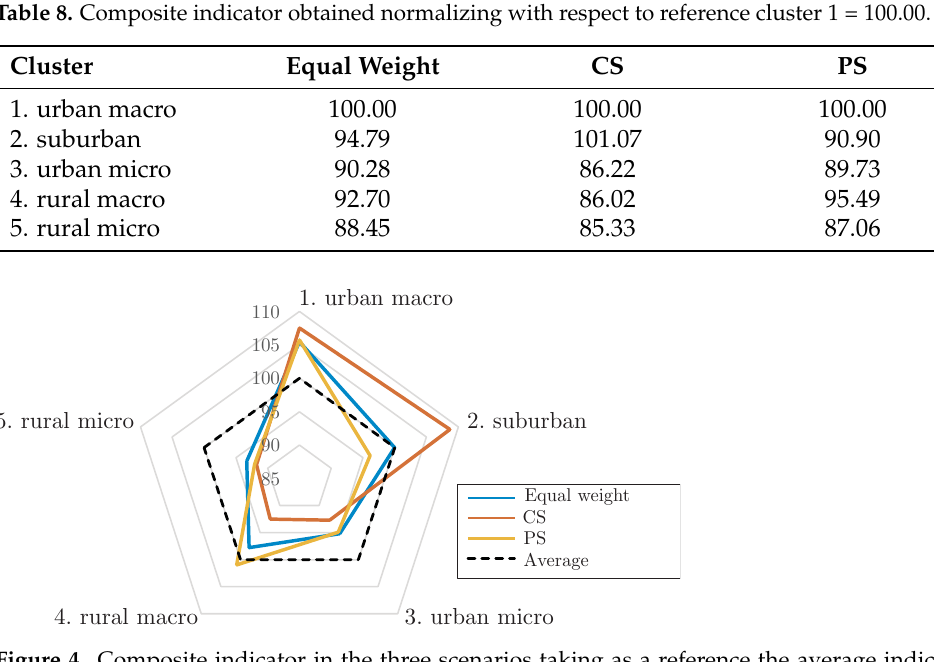
Figure 4. Composite indicator in the three scenarios taking as a reference the average indicator. Average indicator = 100.00.